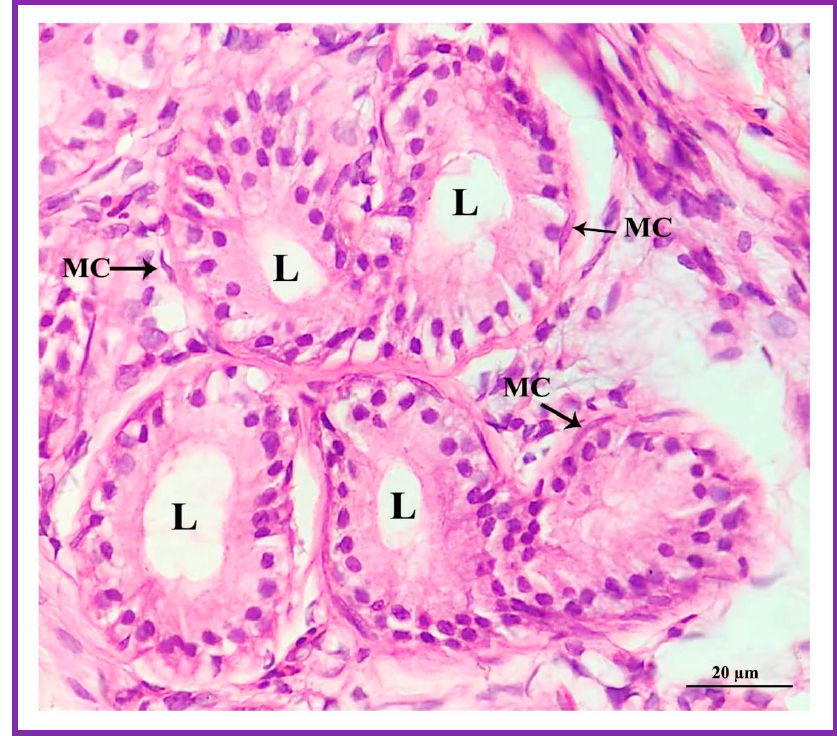
Figure 9. The apocrine gland is surrounded by collagenous or interlobular connective tissue of the hypodermis. The myoepithelial cells (MC) surround the apocrine tubules. L: lumen. The interdigital glandular tissue of male and female Vembur sheep contains nor- mal/ordinary holocrine sebaceous secretory lobules. The secretory acini (i.e., serous, and mucous acinar cells) of the holocrine sebaceous glands are tear-shaped, with a clearly vis- ible cell membrane and nucleus. The sebaceous glands empty directly on the skin surface and most of the secretory lobules open into the hair follicles. The combined sebaceous alveoli form a kind of excretory duct through which the secretion is discharged into the lumen of the pouch (Figure 10). The cells lie closer to the center of the alveoli and become progressively large. The cytoplasm is distended with fat droplets. The cells show a grada- tion of secretory activity from the deposition of single fat globules to the disintegration of the cells. The nuclei shrink in the process and finally disappear altogether. Cells lost in secretion are replaced by the peripheral cells. When the fat of the cells is extracted using a solvent, the cytoplasm becomes honeycomb in appearance (Figure 11).